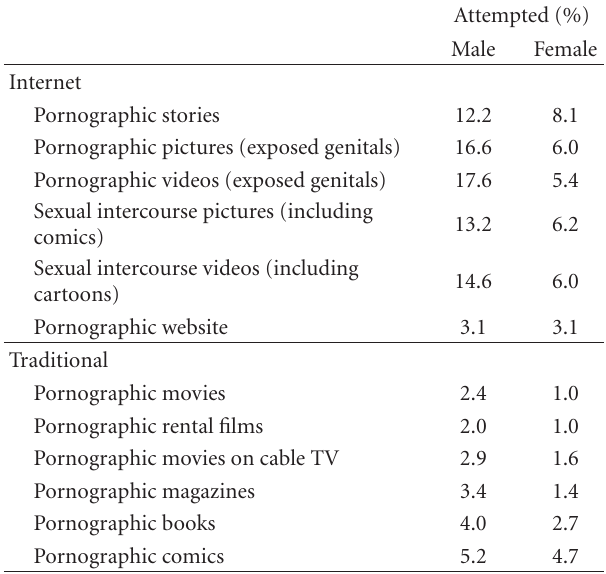
Table 3: Past year exposure to internet and traditional porno- graphic materials by